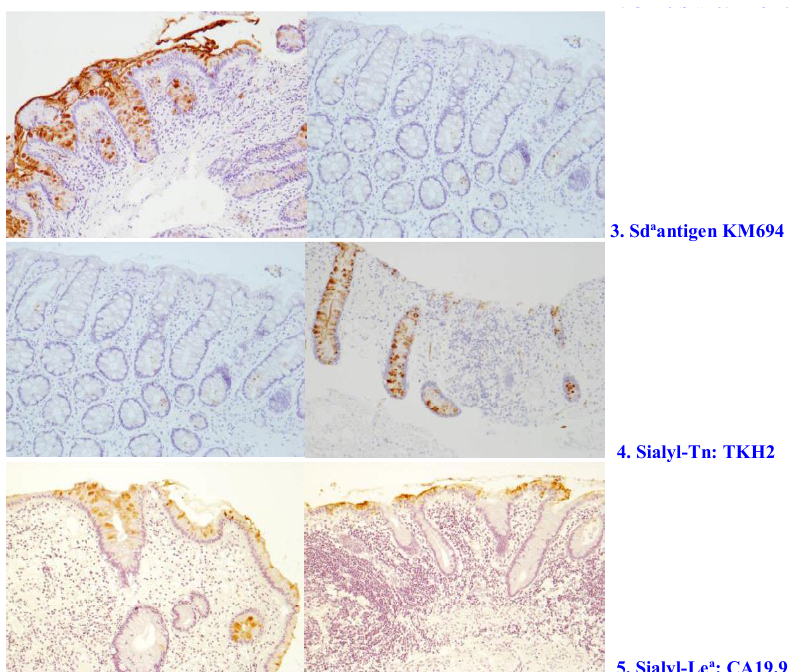
Figure 5. Modulation of Glycan expression after Faecal Diversion. Human colic tissue samples were stained using the antibodies for the epitopes indicated. Note that 1 and 2 represent different antibodies that bind to O -acetylated sialic acids.